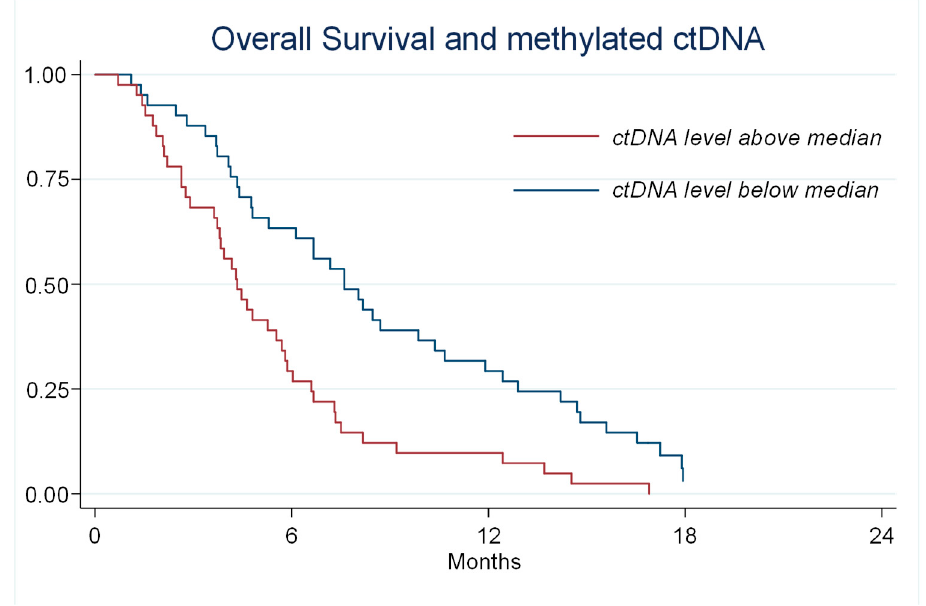
Figure 4. Kaplan–Meier Plots describing overall survival for patients with a level of methylated circulating tumor (ct) DNA above or below the median. Median survival was 7.6 vs. 4.3 months, p <